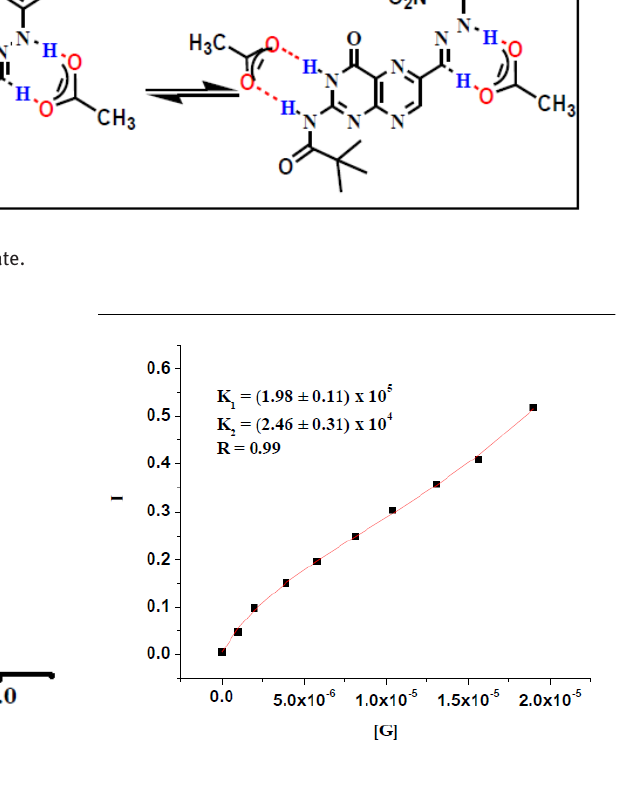
Colorimetric studies: